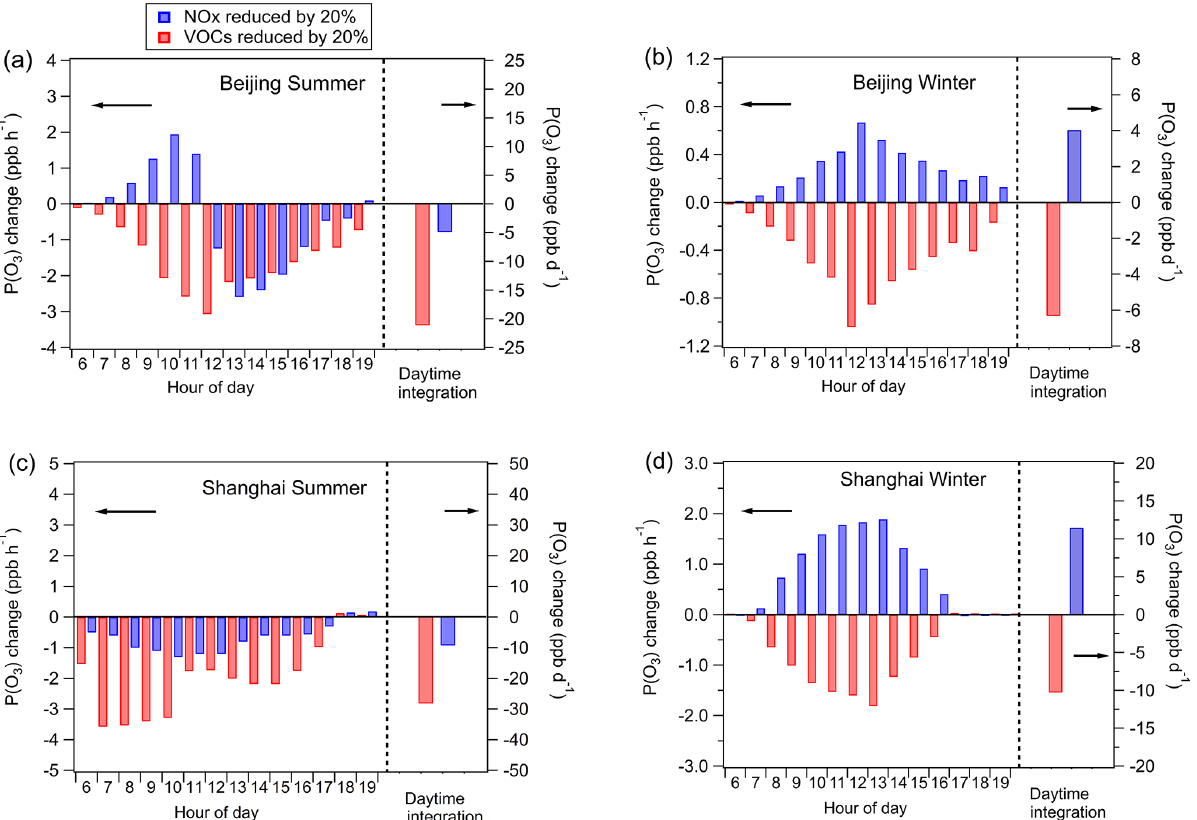
Figure 10. Sensitivity of net ozone production rate [ P (O 3 )] to 20% reductions in emissions of VOCs and NO x for summer and winter of 2019 in Beijing and